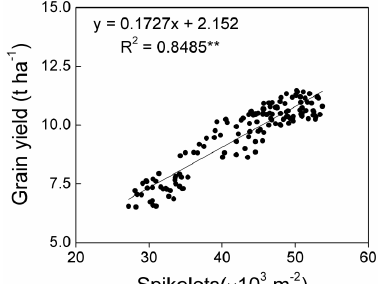
Figure 4. Relationship between grain yield and spikelets per unit area. Data were obtained from all the treatments at Shenyang and Anshan from 2015 to 2016. ** p ≤ 0.01.